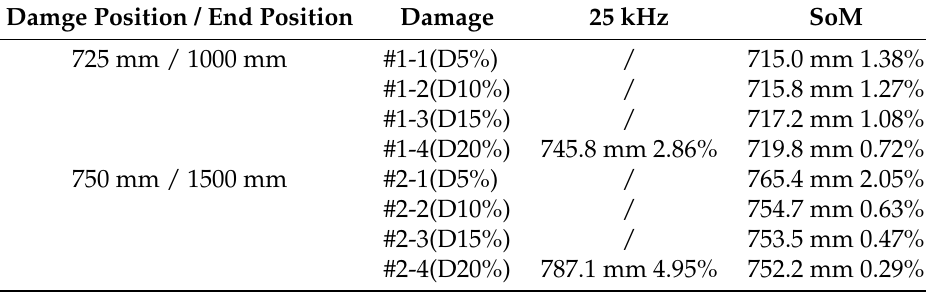
Table 5. Experimental damage localization and error